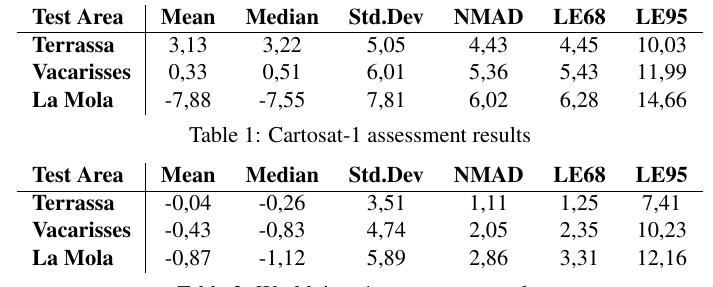
Table 2: Worldview-1 assessment